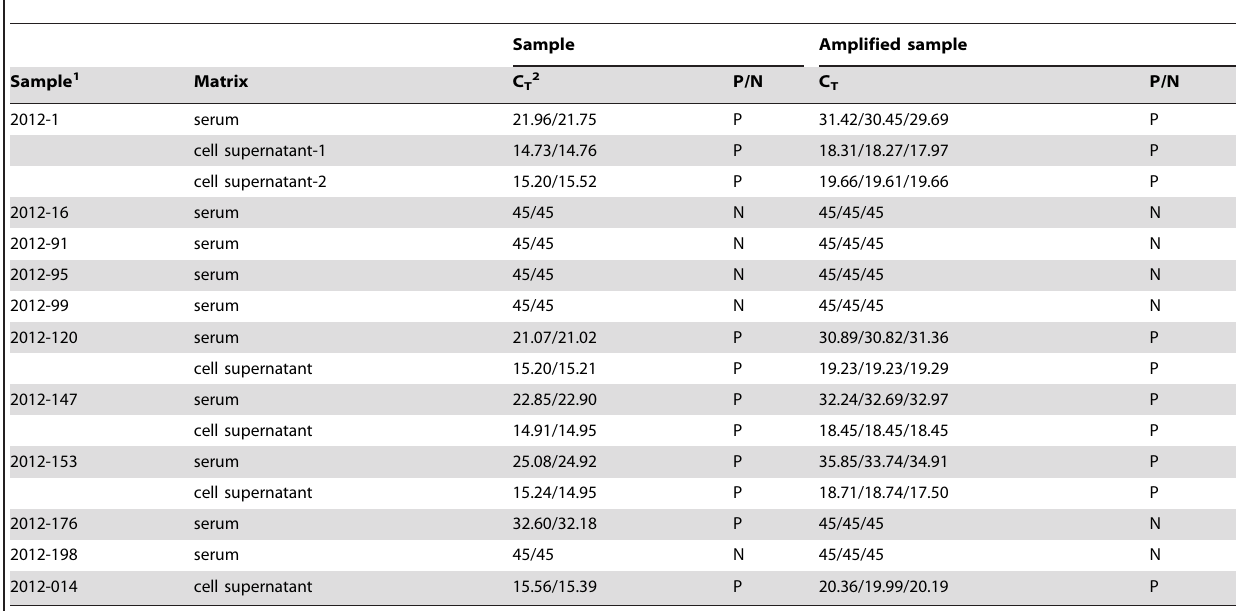
Table 2. Real-time PCR identification of BDBV in human clinical sera samples.